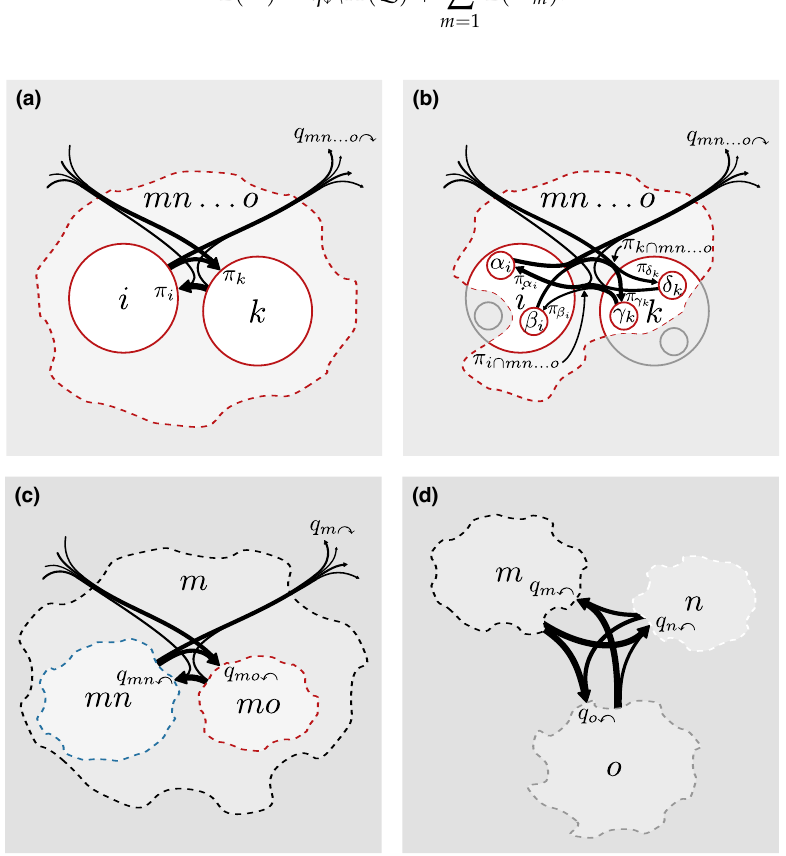
Figure 3. Network flows at different modular levels. Large circles represent physical nodes, small circles represent state nodes, and dashed areas represent modules. ( a ) Finest modular level with physical nodes for first-order network flows; ( b ) Finest modular level with physical nodes and state nodes for higher-order network flows; ( c ) Intermediate level; ( d ) Coarsest modular